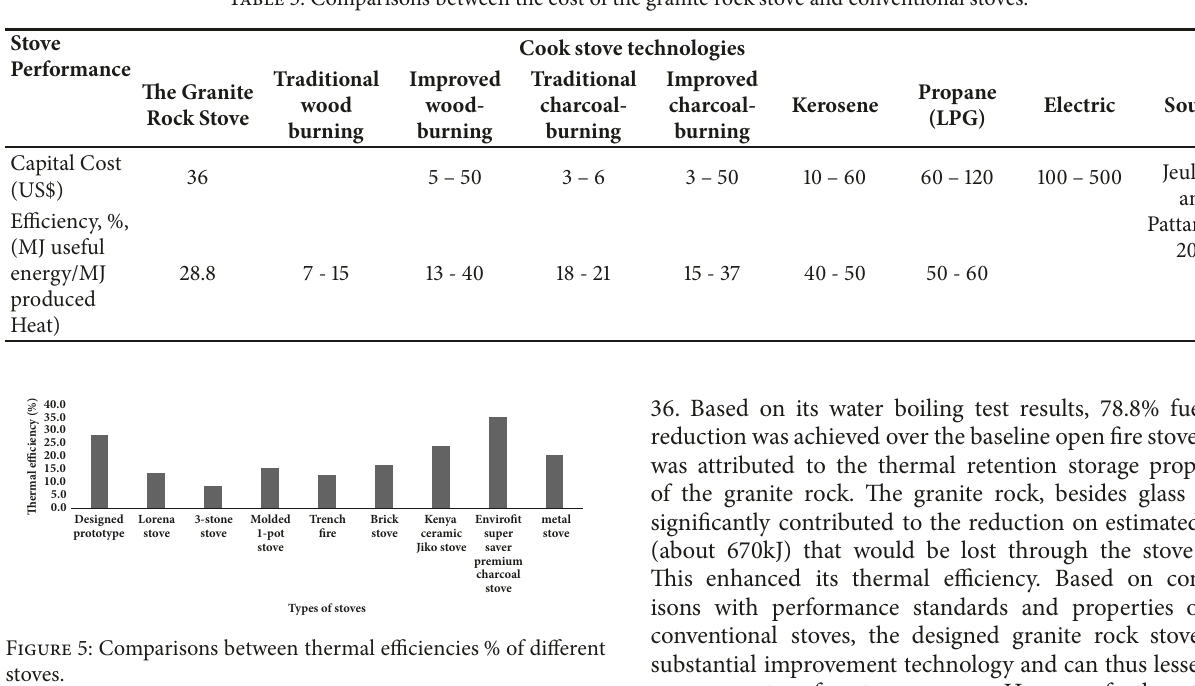
Table 5: Comparisons between the cost of the granite rock stove and conventional stoves.